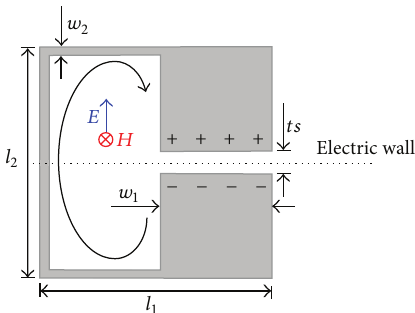
Figure 1: Typical topology of a folded SIR and relevant dimensions. The resonator can be excited by a time varying electric or magnetic field oriented in the indicated directions. The distribution of current and charges is also